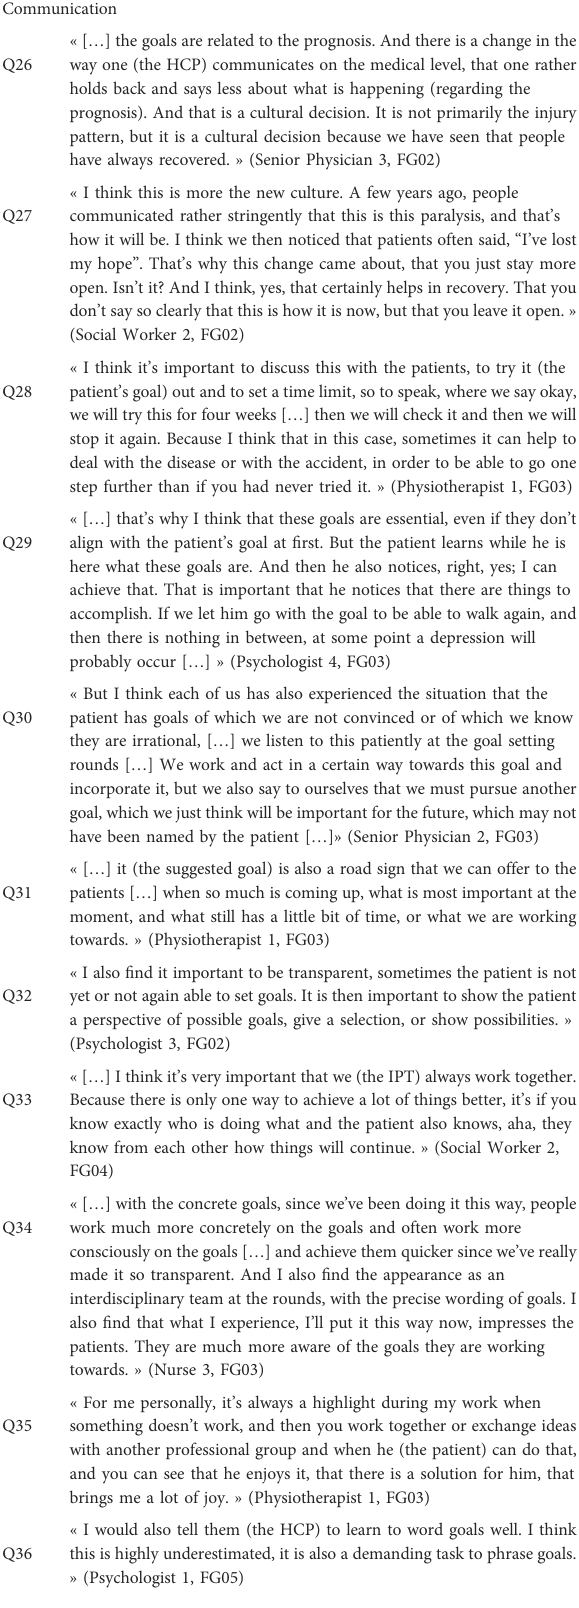
TABLE 4 The micro level -